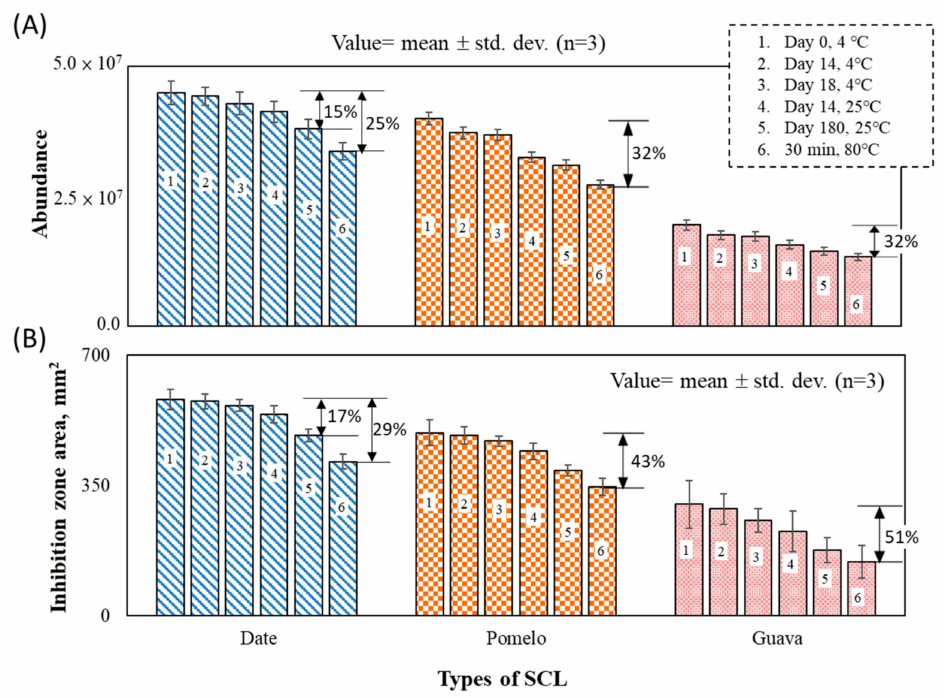
Figure 3. Plots of abundances ( A ) and inhibition zone areas ( B ) versus the three SCLs.